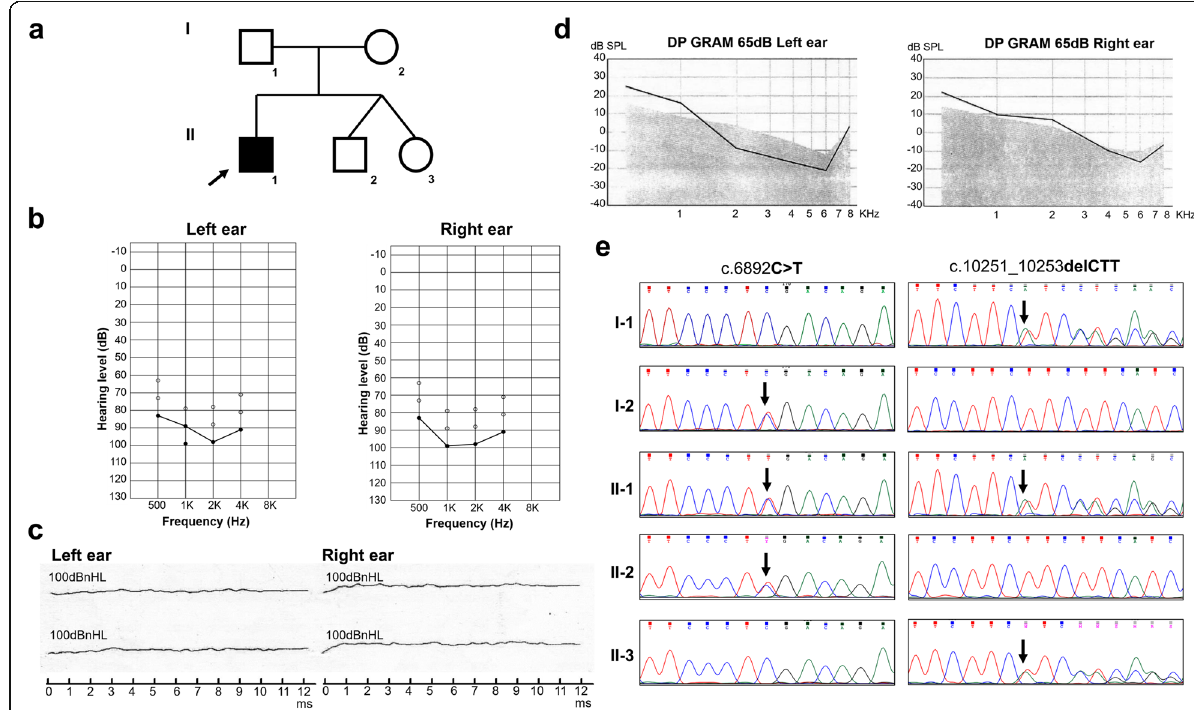
Fig. 1 Molecular genetics and clinical analysis. a Family pedigree diagram. Filled symbols and opened symbols indicate affected and unaffected individuals, respectively. Arrows indicate the proband in this family. b Auditory steady state response (ASSR) audiogram of left and right ears of the affected proband showed profound hearing loss. c Auditory brainstem response (ABR) demonstrated no waveforms response for click stimulus at 100 dB HL of both ears of the proband. d Distortion product otoacoustic emission (DPOAE) audiogram of both ears of the proband. The DPOAE were detected in 500, 1,000, 2,000, 4,000, 60,00, and 8000 Hz frequencies. The stimulus tolerance is 5 dB above noise level. e Sanger sequencing results of the c.6892C > T and c.10251_10253delCTT variants in all family members. Arrows indicate the position of the nucleotide changes identified in this study. I-2, II-1, II-2 carried the 6892C>T mutation in MYO15A , and I-1, II-1, II-3 carried the c.10251_10253delCTT mutation in